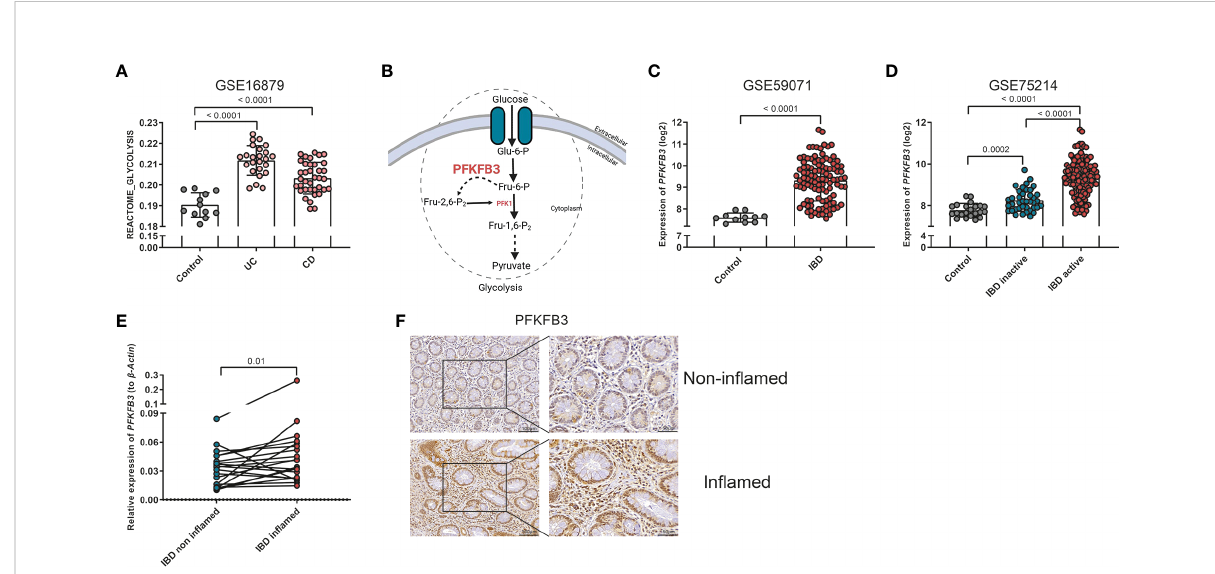
FIGURE 1 Elevated glycolysis and PFKFB3 expression in IBD samples. (A) ssGSEA analysis of GSE16879, glycolysis score of each sample is displayed in the graph (Control, n=12 (normal intestine), UC, n=24, CD, n=37). (B) Schematic overview on the role of PFKFB3 in the glycolysis process. (C) PFKFB3 expression in dataset GSE59071 (Control, n=11, IBD, n=105). (D) PFKFB3 expression in dataset GSE75214 (Control, n=22, IBD inactive, n=39, IBD active, n=133). (E) Relative expression of PFKFB3 , corrected for b -Actin as a housekeeping gene in LUMC-IBD biobank tissues (n=20, paired samples, non-in fl amed/in fl amed). (F) Representative immunohistochemical staining for PFKFB3 in human IBD tissues (n=9, paired sample, non-in fl amed/in fl amed, scale bar, 100 m m (left) or 50 m m (right)). The data are presented as the mean ± SD. One-way ANOVA (A, D) , non-paired two-tailed t-test (C) , and Wilcoxon test (E) were